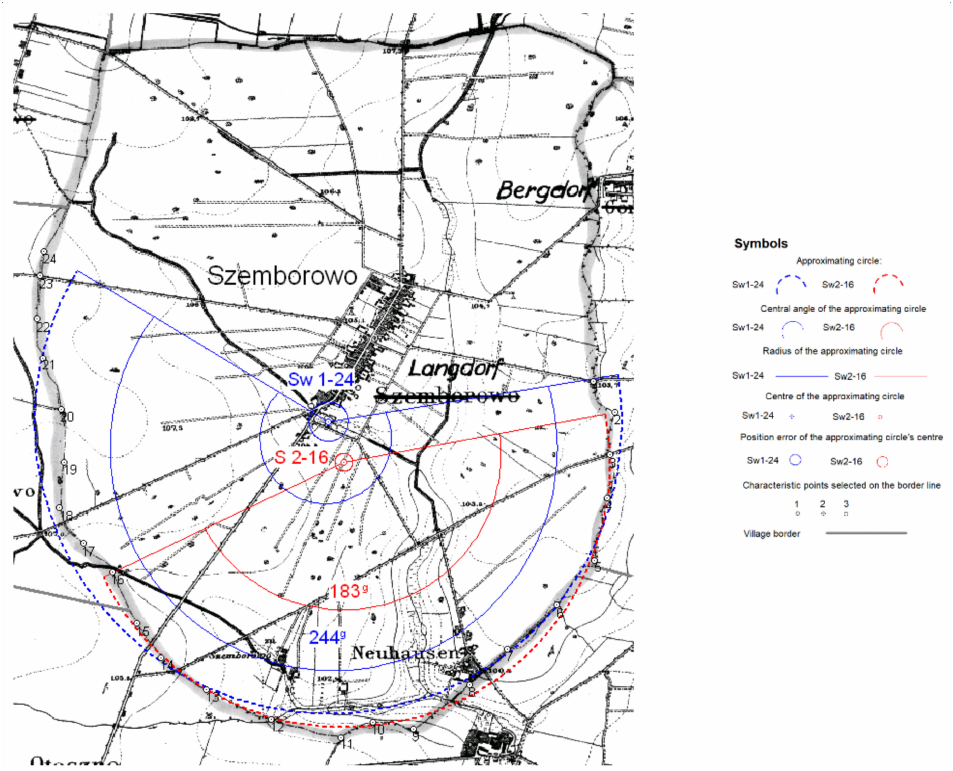
Figure 6. Szemborowo. The course, position and error of the approximating circle: Sw 1—24— approximation of points 1—24; S 2—16—approximation of points 2—16. Scale 1:50,000.